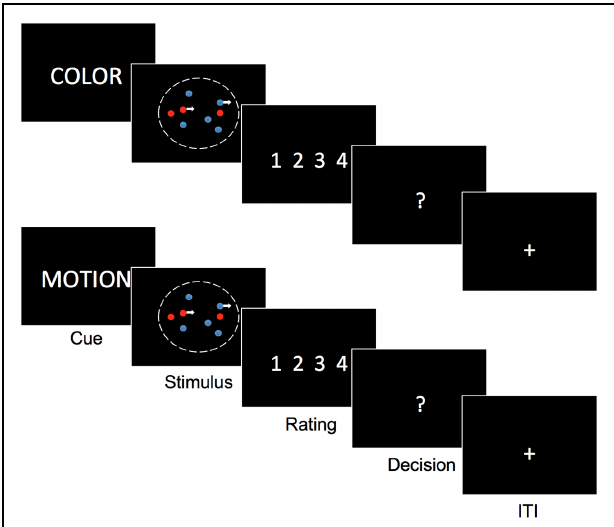
FIGURE 1 | Task description. subjects see on the display a cloud of colored moving dots. In the beginning of each trial they are cued whether to attend motion and ignore color or attend color and ignore motion. Depending on the cue after stimulus presentation (750 ms) they have to rate their degree of certainty that motion was to the left or right or that one color was more present than the other (blue or red). Only after the certainty rating, they indicate the respective direction or color. Task modified from Kayser et al.